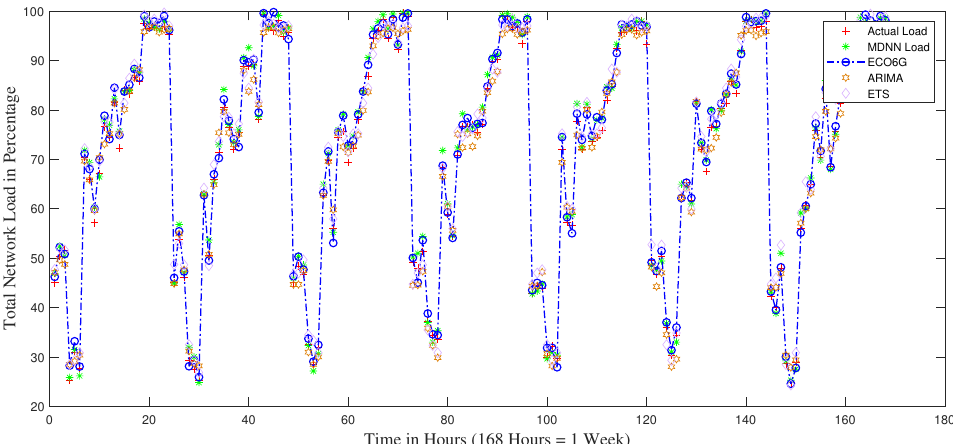
Figure 3. Simulation results of Network Load Prediction using Neural Network and Statistical Modeling.